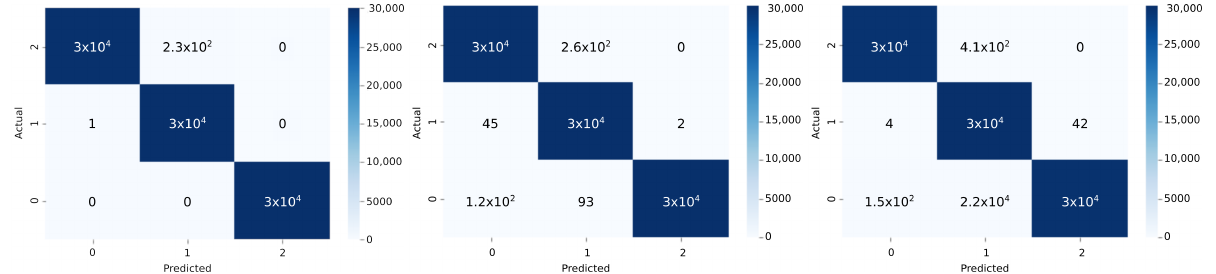
Figure 10. Confusion matrices: From left to right: base network, quantized network and pruned network. Label 0: electron, label 1: muon and label 2: electric